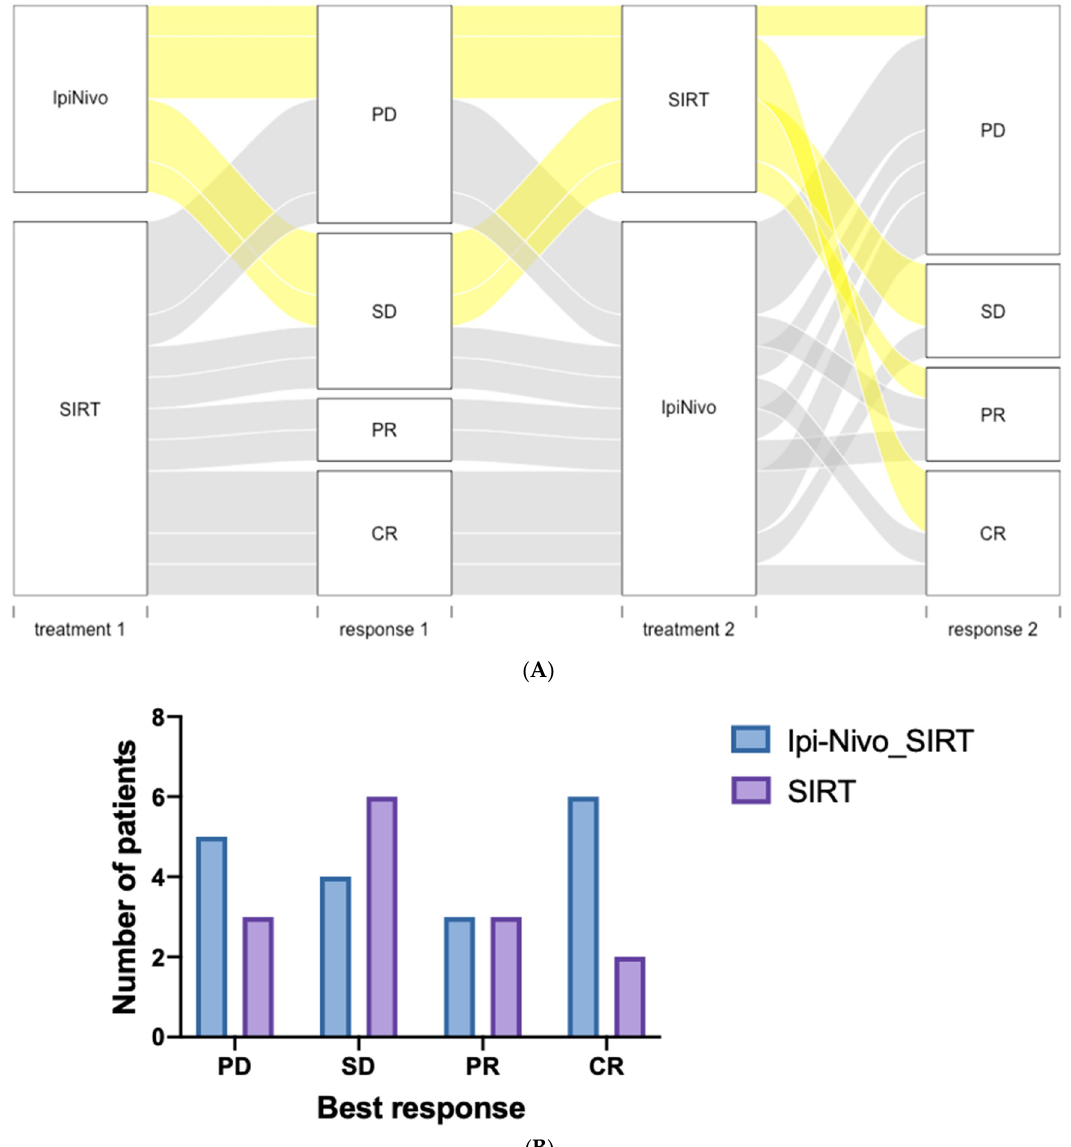
Figure 2. ( A ) Alluvial plot of best response to first treatment received, either SIRT or ipilimumab plus nivolumab (IpiNivo), and best response to the second treatment. ( B ) Liver responses to SIRT by group. CR: complete response; PR: partial response; SD: stable disease; PD: progressive disease. Median hPFS and median progression-free survival (mPFS) from the first SIRT was 8.7 (95% CI; 4.4-NA) and 4.6 (95% CI; 2.7–10) months in the SIRT_IpiNivo group and 5.6 (95% CI; 4.9-NA) and 4.9 (95% CI; 4.1-NA) months in the SIRT group (Figure 3). The median hepatic duration of response was 13.3 months (range: 2.1–28.5 months) in